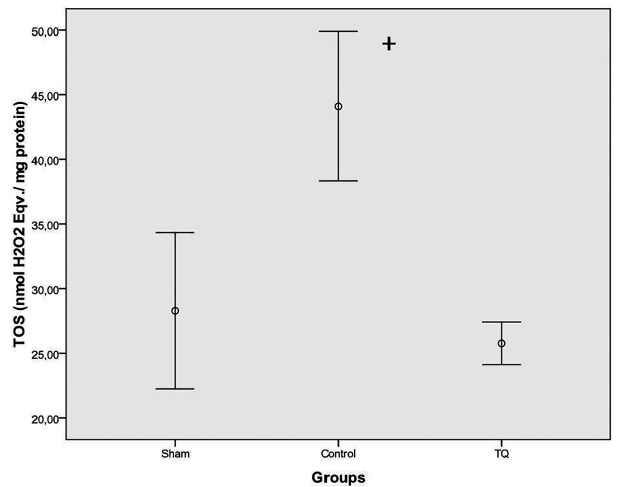
Fig. 2 - TOS levels in sham, control, and thymoquinine groups. + P<0.001 (for all comparisons) compared with sham and thymoquinine groups